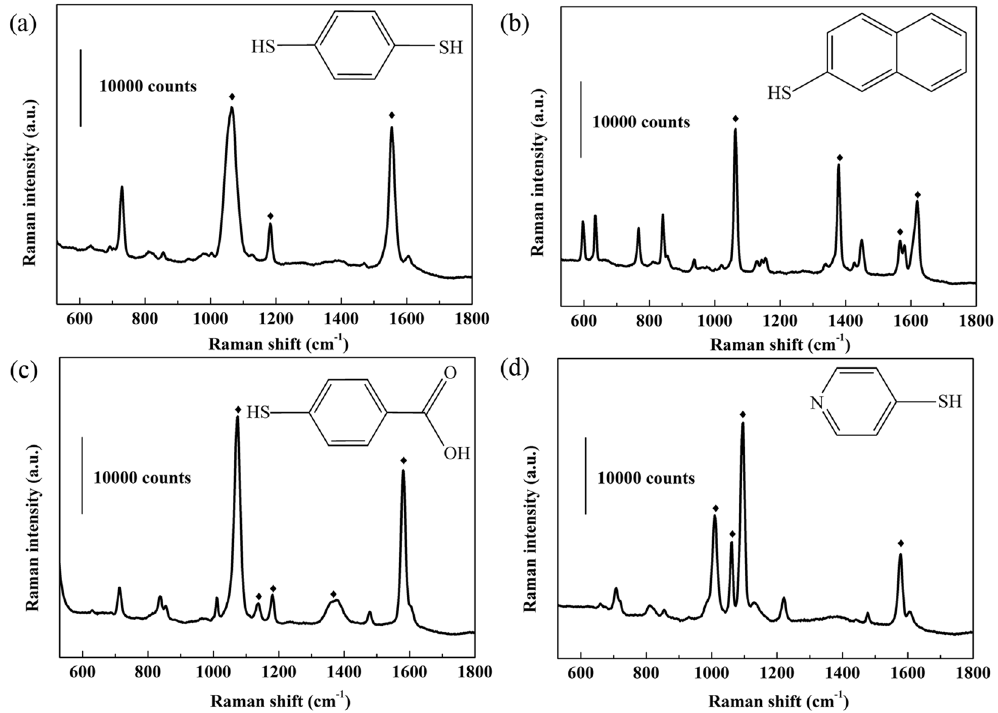
Figure 2. SERS spectrum of ( a ) 1, 4-BDT, ( b ) 2-NaT, ( c ) 4-MBA, and ( d ) 4-MPY.